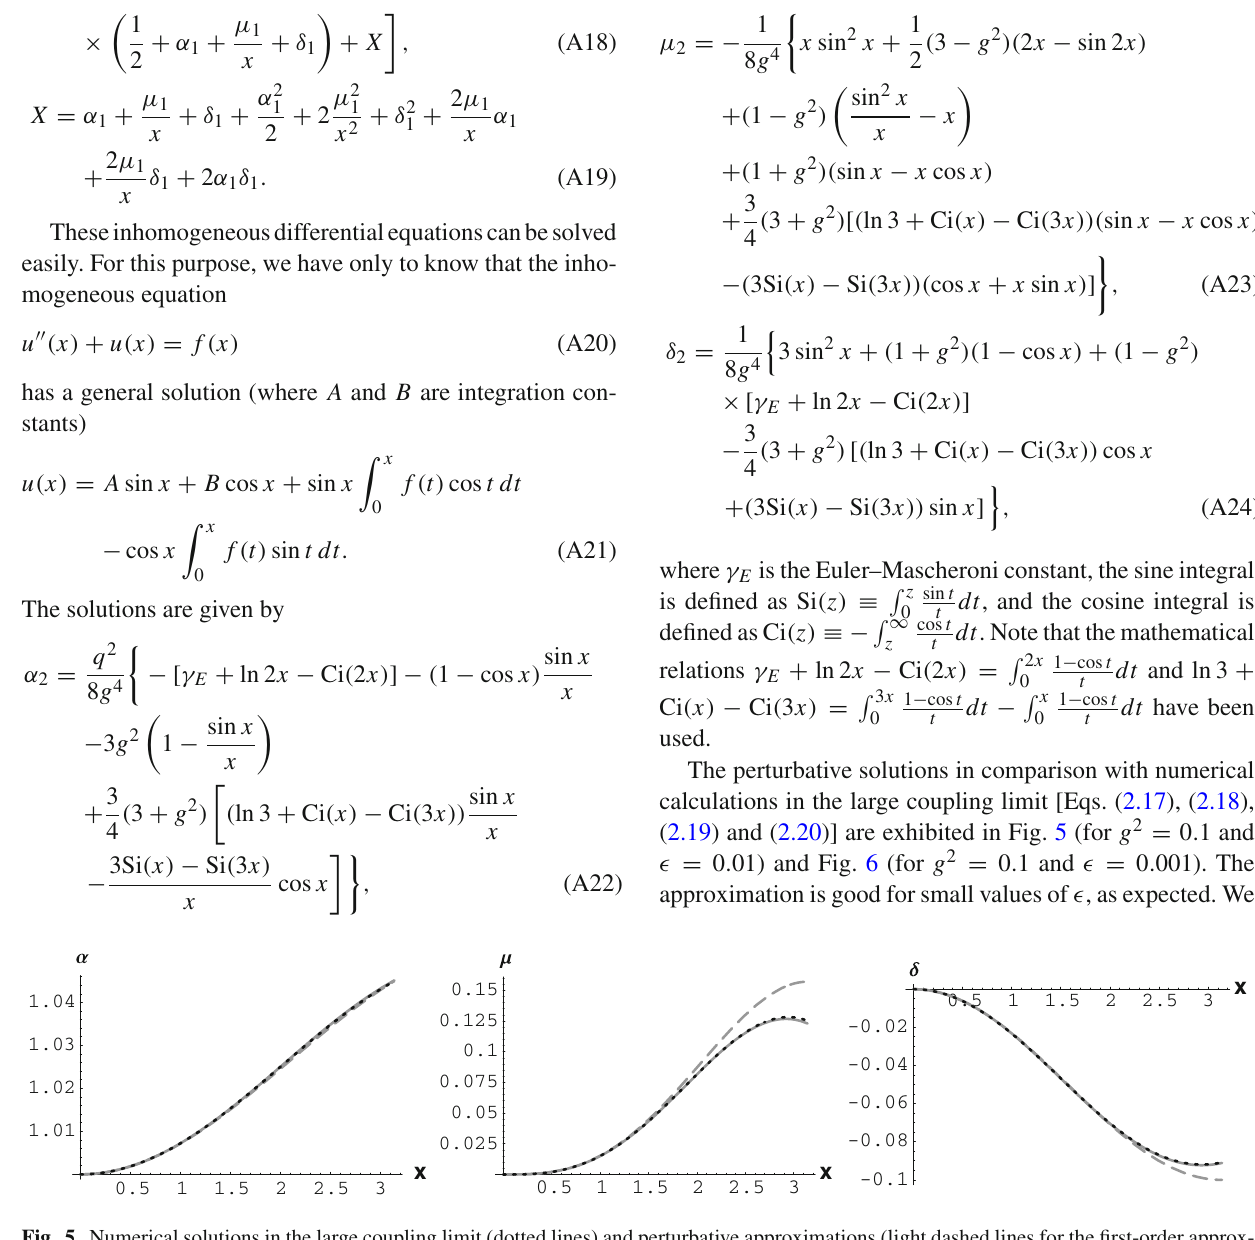
Fig. 5 Numerical solutions in the large coupling limit (dotted lines) and perturbative approximations (light dashed lines for the first-order approx- imations in (cid:2) and light solid lines for the second-order approximation in (cid:2) ) for α( x ) , μ( x ) , and δ( x ) on the interval [ 0 ,π ] , where g 2 = 0 . 1 and (cid:2) = 0 . 01